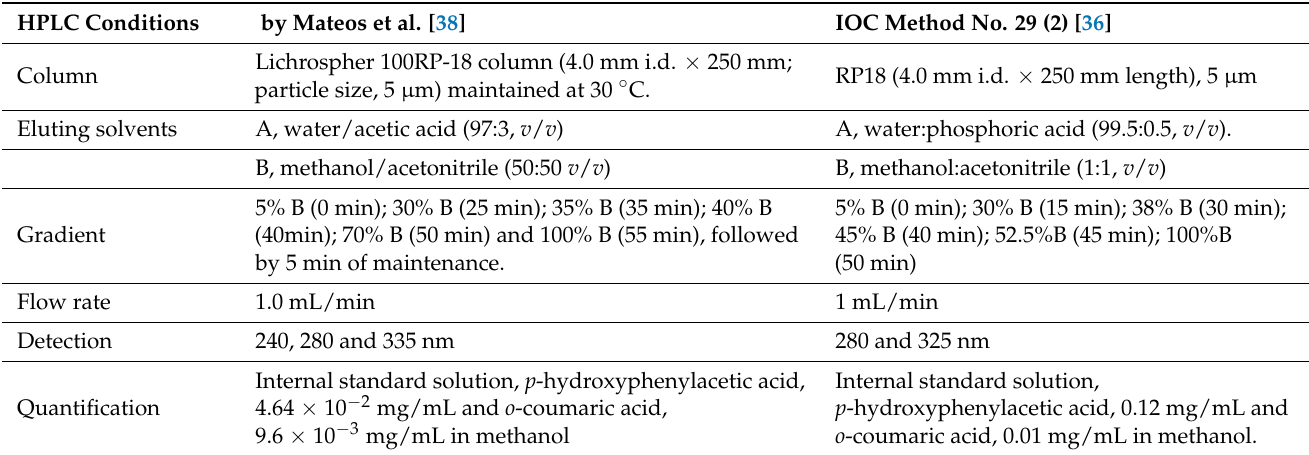
Table 4. HPLC conditions proposed for ‘olive oil polyphenols’ according to